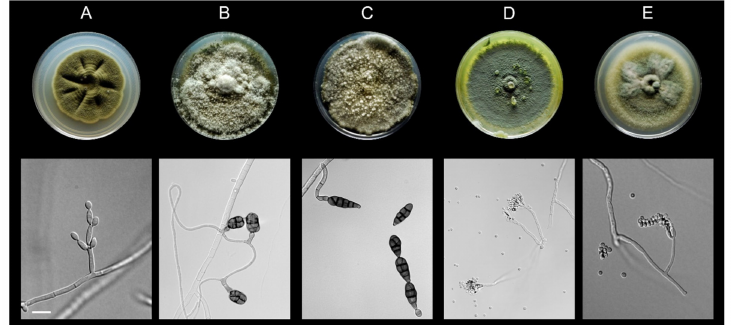
Figure 2. Macromorphology and micromorphology of the fungal isolates recovered from deep-sea sediment samples evaluated for their capacity to degrade petroleum. Top row: colony morphology of strains grown on Petri dishes containing potato dextrose agar medium. Bottom row: conidiophores and conidia of the fungal strains imaged by Differential Interference Contrast microscopy. Scale bar = 10 µ m. ( A ) Cladosporium halotolerans , ( B ) Stemphylium sp., ( C ) Alternaria sp., ( D ) Penicillium sp. 1, and ( E ) Penicillium sp. 2.